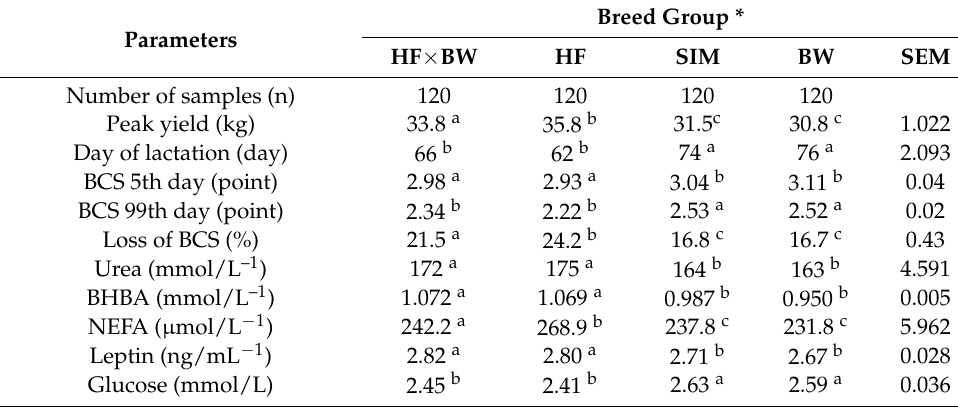
Table 2. Average yield at the peak of lactation and parameters of energy metabolism in the breed groups. Breed Group * Parameters HF × BW Number of samples